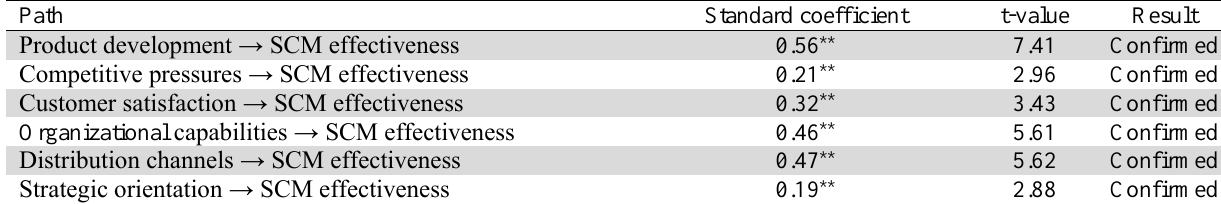
The summary of the results of SEM implementation